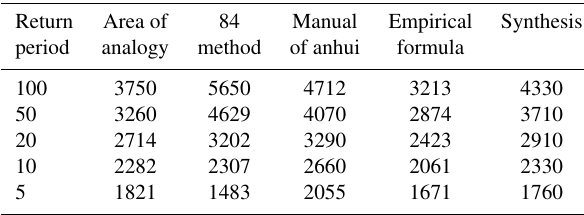
Table 3. Design flood results of Shitai water level